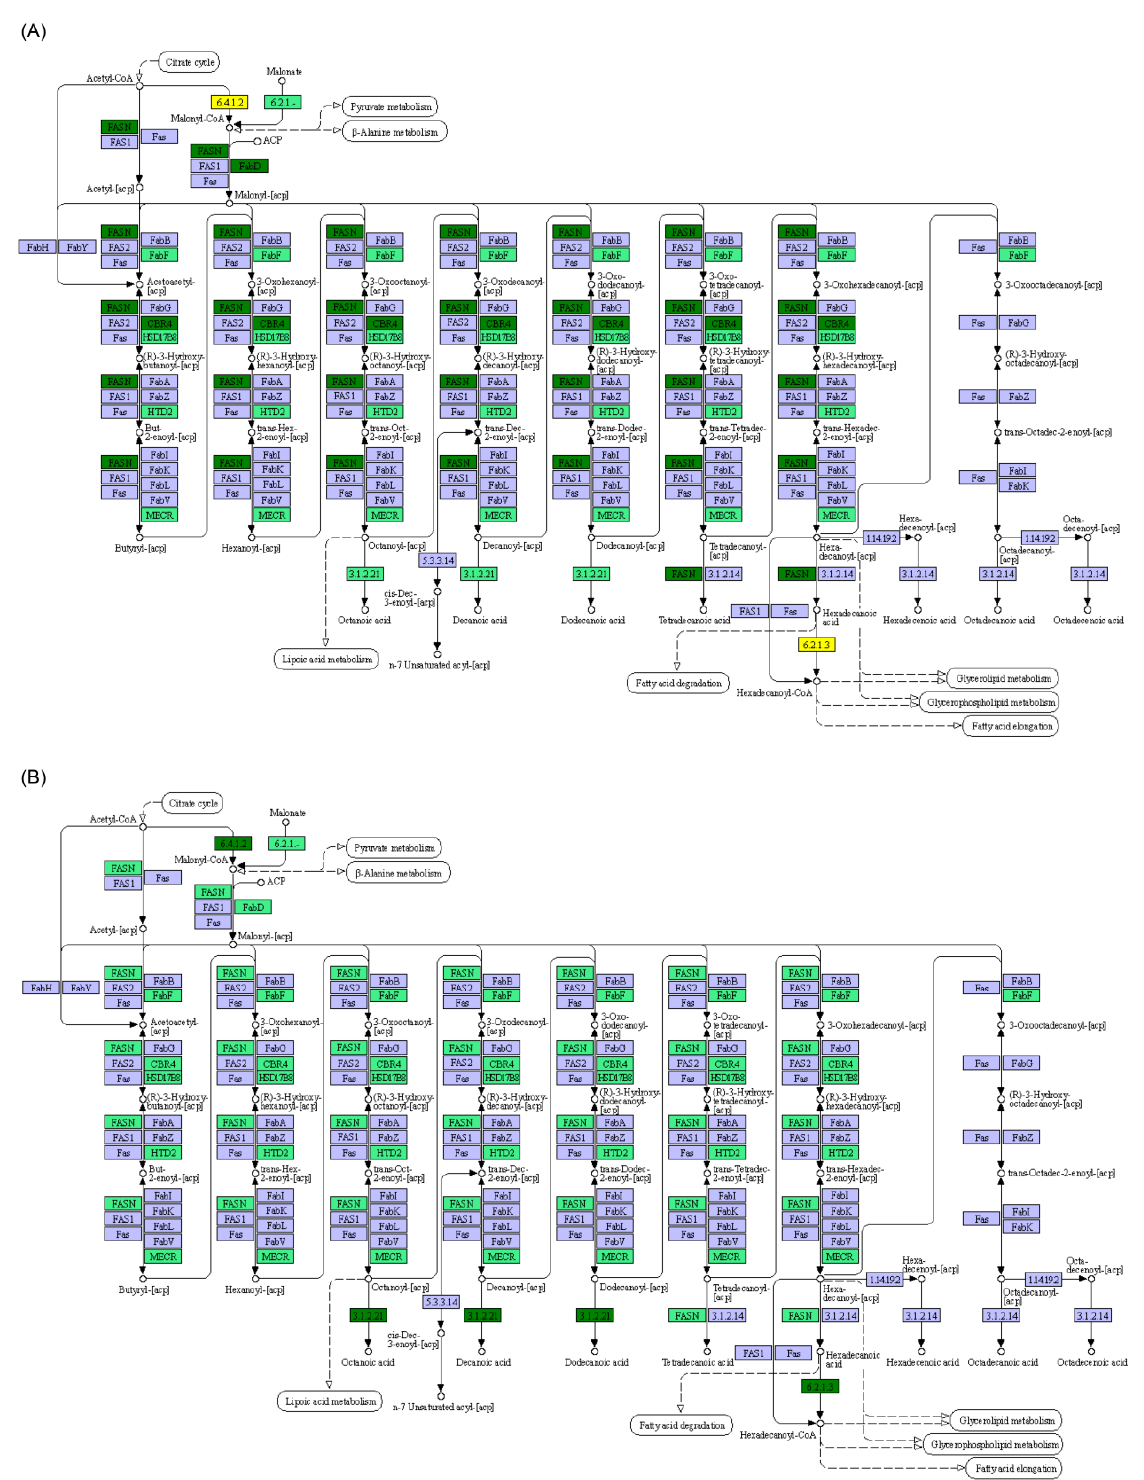
Figure 8. Kyoto Encyclopedia of Genes and Genomes pathway showing the significantly upregulated and downregulated genes involved in fatty acid biosynthesis in the liver transcriptome of yellowcheek starved for ( A ) 8 and ( B ) 28 d compared to the control groups at the same time. Dark green, yellow, light green, and light purple indicate significantly downregulated genes, both upregulated and downregulated genes in the corresponding genes, the genes of the species annotated on the map, and the genes that were not annotated on the map,